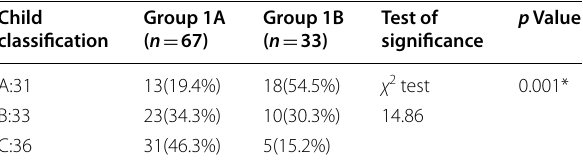
*High significant difference, P < 0.001